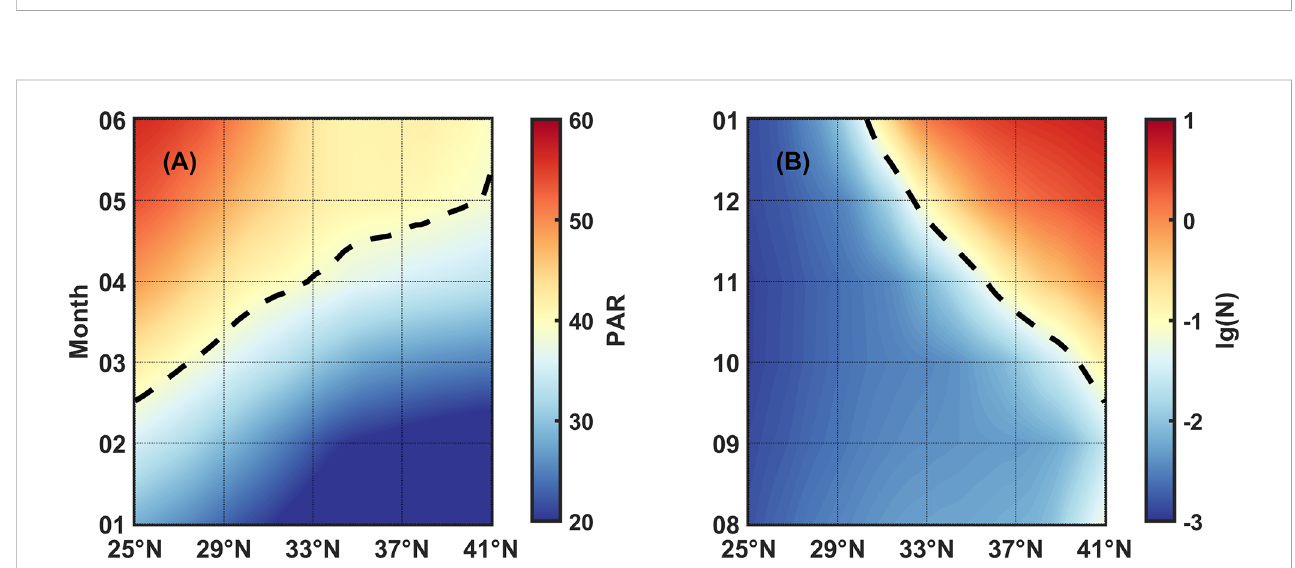
FIGURE 13 (A) PAR and (B) N varying with latitudes and months. Color represents the values of PAR and N, the broken lines indicate isoline PAR=39 Einstein/m 2 ·day and N=10 -1.2 mmol/m 3 ,